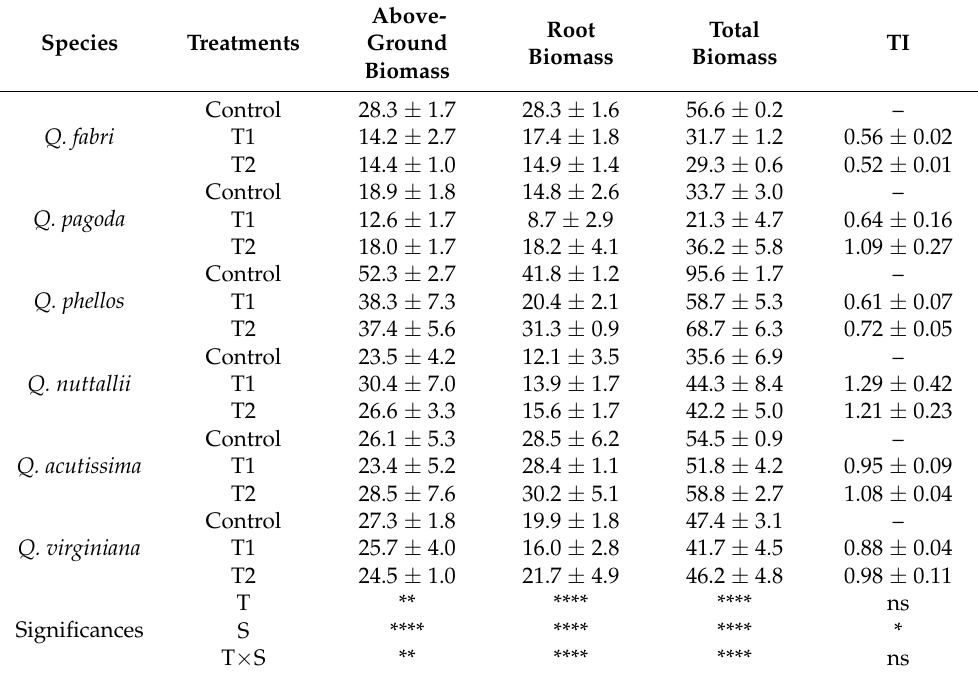
Data represent the mean of three replicates ± SD (n = 3). p values of the two-way ANOVAs of soil treatments (T), oak species (S), and their interactions (T × S) were also shown. ns, not significant; *, p ≤ 0.05; **, p ≤